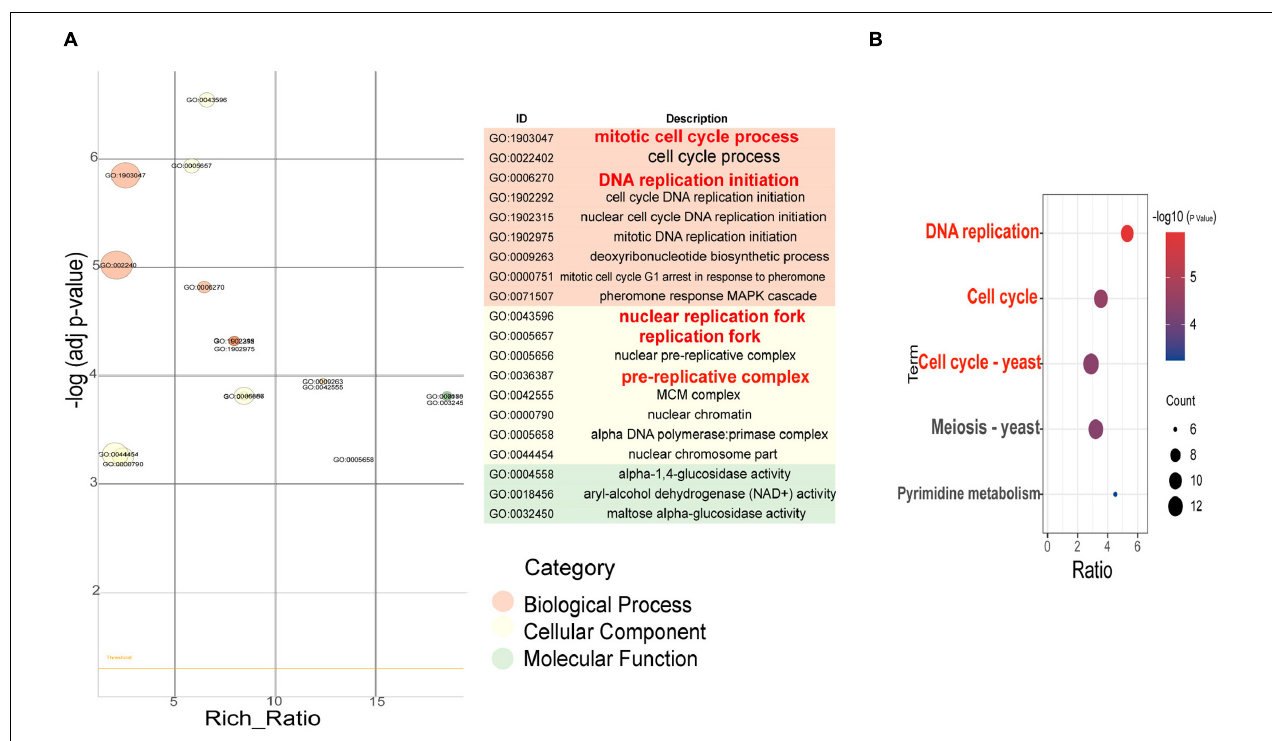
FIGURE 4 | GO enrichment item and KEGG enrichment pathway q value scatter plot of differentially expressed genes between F94 strain and PR strain. (A) GO enrichment item q value scatter plot. (B) KEGG enrichment pathway q value scatter